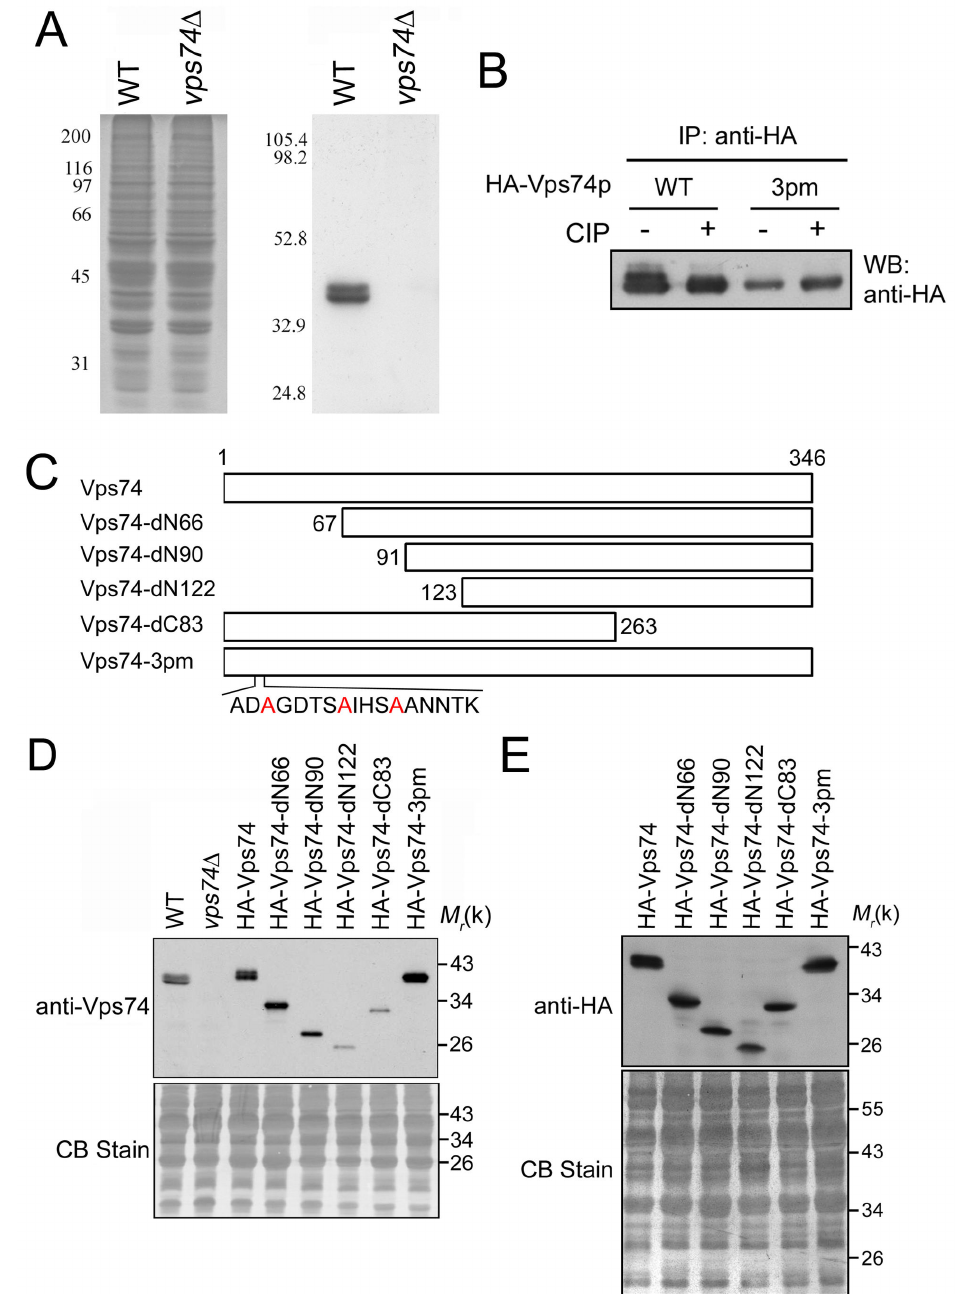
Figure 1. Vps74p is a phospho-protein. (A) The anti-Vps74p antibody is specific, Western blot analyses of crude lysates of wild- type (WT) and vps74 Δ mutant yeast probed with antibodies against Vps74p (right) and SDS-PAGE stained with Coomassie Blue (left) demonstrates the specificity of the Vps74p antibody. (B) Cell lysis and immunoprecipitation assays were performed as described in the Materials and methods section. Immunoprecipitated proteins were separated into two equal portions and incubated at 37°C in CIP buffer for 1 h in the absence or presence of CIP. Each sample was subjected to SDS-PAGE followed by Western blotting using anti-HA antibody. (C) Schematic representation of the structure of the 346-residue Vps74p polypeptide and various mutant constructs is illustrated. (D) and (E) Expression of wild-type and mutant proteins is dipicted. HA epitope-tagged wild-type (WT) Vps74p, Vps74p-dN66, Vps74p-dN90, Vps74p-dN122, Vps74p-dC83, and Vps74p-3pm were expressed from 2μ-based plasmids (pVT101U) under the control of the ADH promoter in BY4741 yeast strain and detected by western blotting using the indicated antibodies. doi: 10.1371/journal.pone.0074715.g001 PLOS ONE |